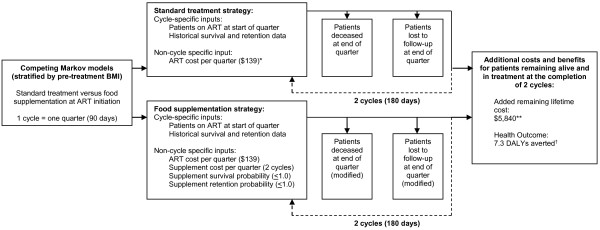
Design of the cost-effectiveness model. *ART cost per quarter calculated as the average cost per ART year ($556) divided by four. This figure represents year one costs and is not subject to discounting. **Added lifetime cost per active ART patient is calculated by subtracting cumulative ART cost accrued during 2 model cycles from an overall cost of $6,118 per death averted, or the lifetime expenditure per patient (discounted at a rate of 3% and accounting for historical rates of second-line ART use). Cost estimates for ART and the switch rate from first to second-line treatment are from a PEPFAR-supported, program-wide cost-effectiveness analysis of 45 public and private-sector centers providing HIV treatment in Zambia between 2004 and 2008.